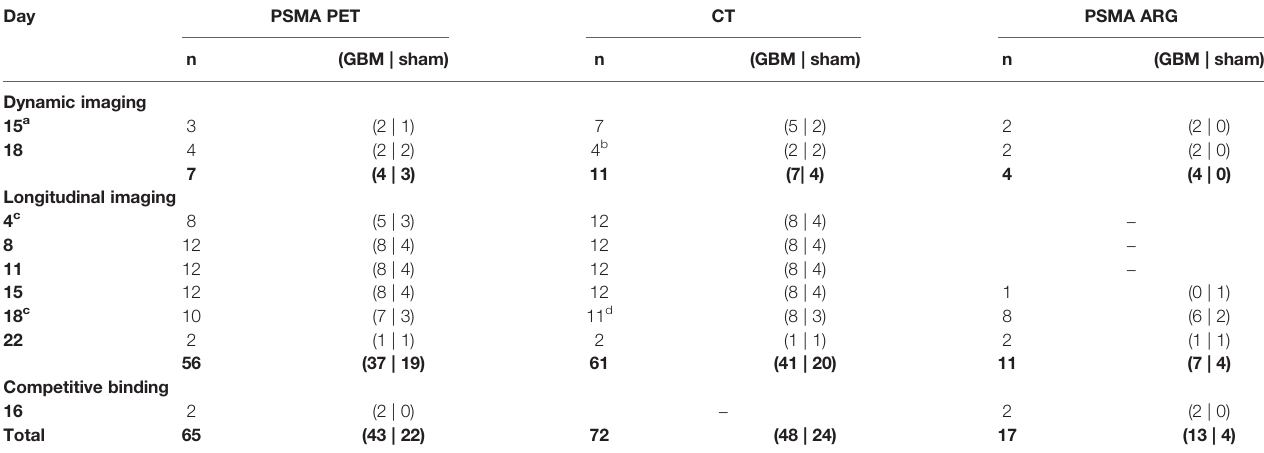
TABLE 1 | Overview study